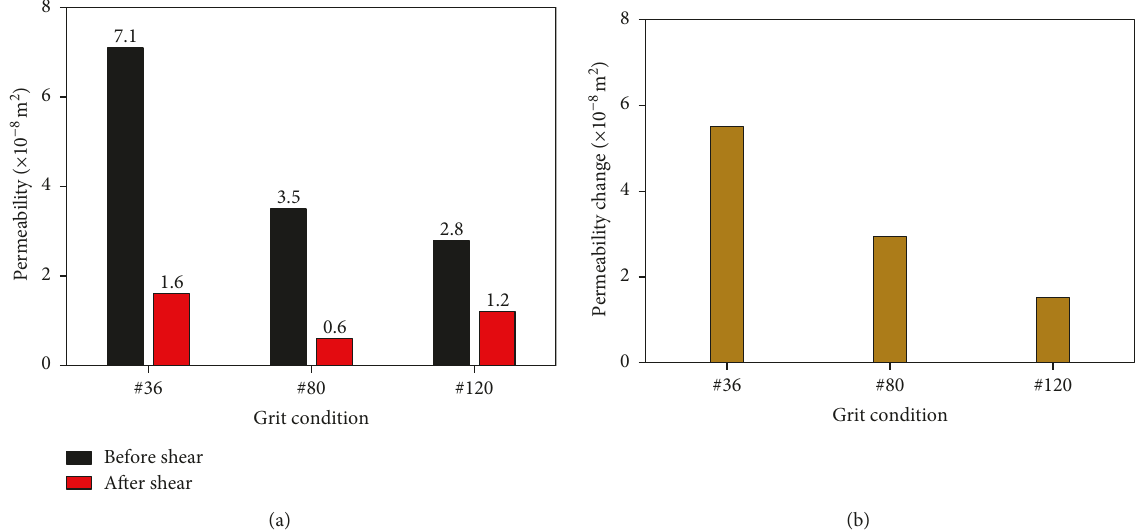
Figure 5: Permeability values of sandstone fractures before and after shearing tests: (a) permeability values before and after shearing; (b) permeability drops of sandstone